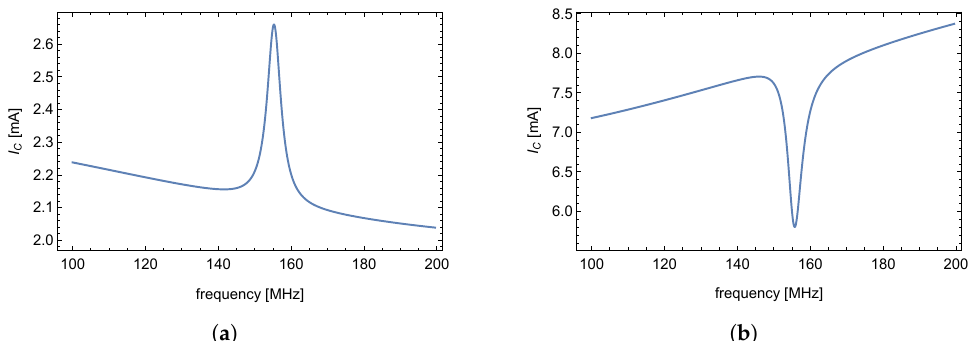
Figure 11. Supply current passing through resistor R 5 as a function of frequency for A class amplifier ( a ). Supply current passing through resistor R 5 as a function of frequency for AB class amplifier ( b